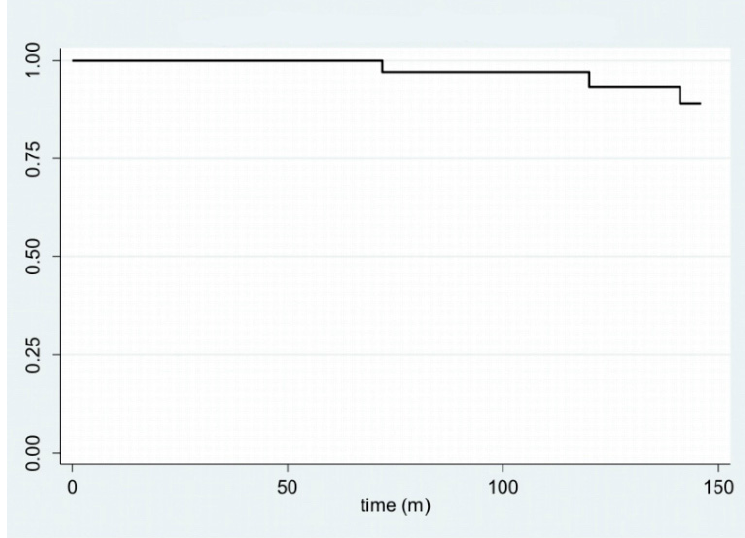
Figure 1. Kaplan–Meier plot for disease-free survival. Finally, a multivariate logistic model was used to evaluate what variables may be independently associated with relapse: the characteristics of the patients (age and anam- nesis), disease (site, size, and histological type), and surgical treatment. We discovered that the only variable independently associated with the onset of relapse is the anatomical site, the maxillary location in particular. Table 6 displays the odds ratios (OR)—relating to the variables described with a confidence interval of 95%—and the p -values for both the univariate and multivariate logistic